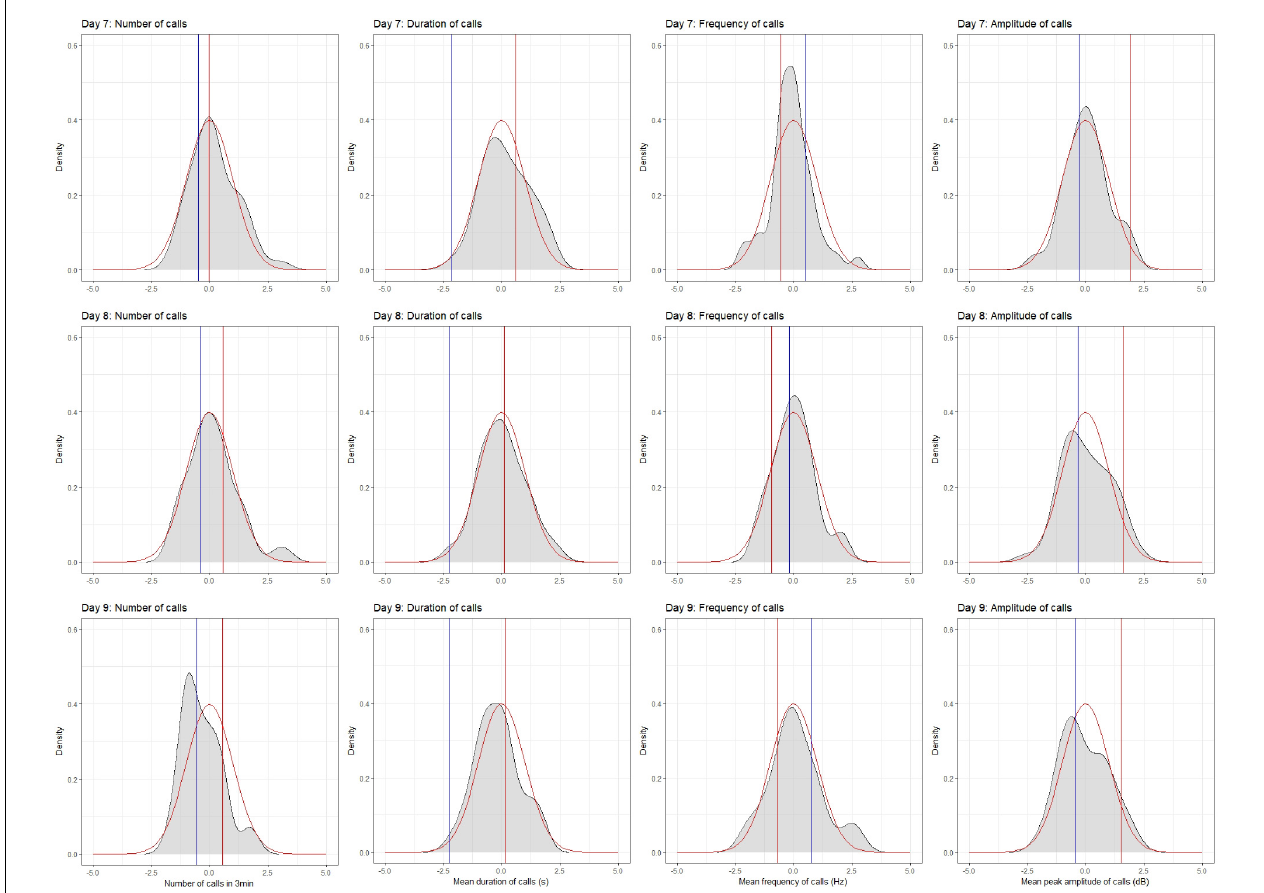
FIGURE 6 | Density plots for the four quantitative traits in the BXD family on postnatal days 7, 8, and 9. Density plots were produced in R using the density function in the stats package and plotted using the ggplot2 package. Values were converted to z -scores, to aid in the comparison between plots. Density is shown in gray. The red line on each plot represents the normal distribution, whereas the red and blue bars represent the mean values for the D2 and B6 parents, respectively.